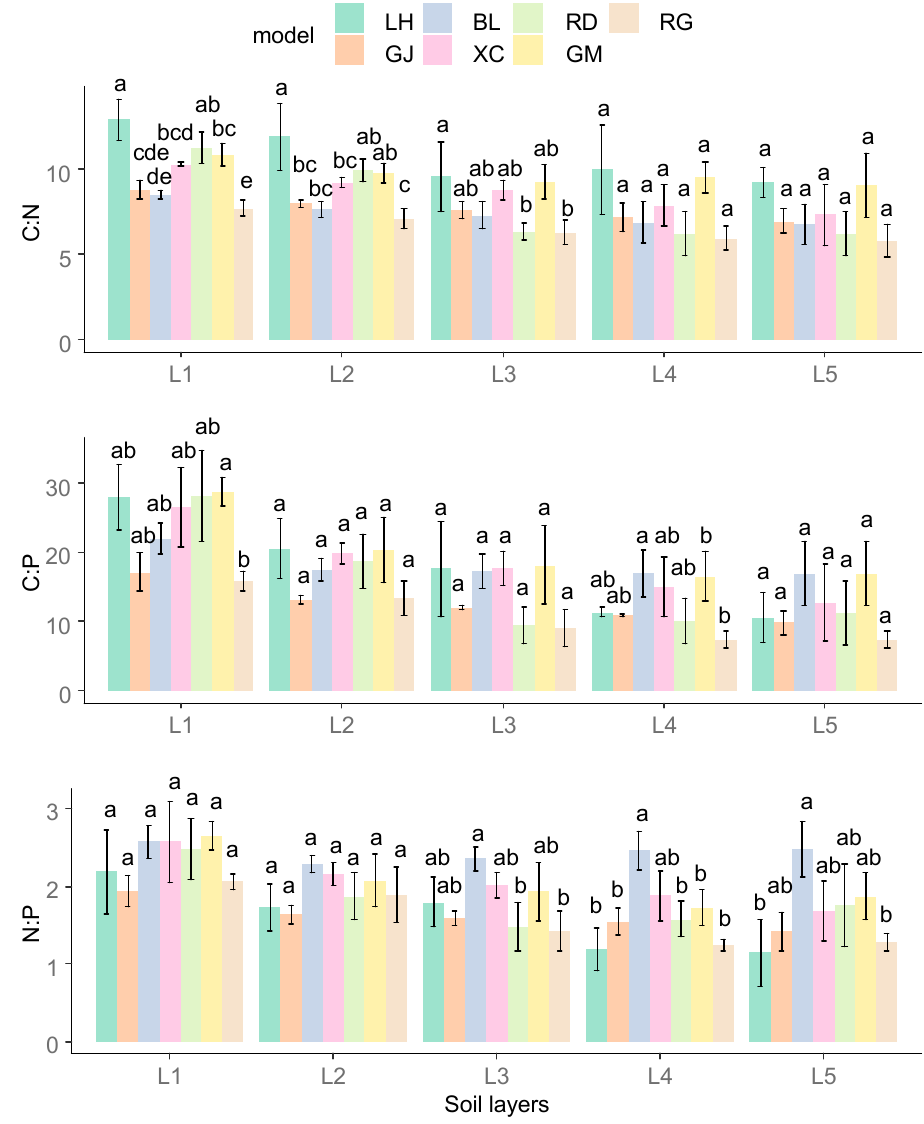
Figure 3. C:N, C:P, and N:P ratios in the different restoration models for each soil layer. Different small letters mean significant differences among restoration models in the different soil layers. Table 2. F and p -values of the independent factors (models, layer) and their interactions.